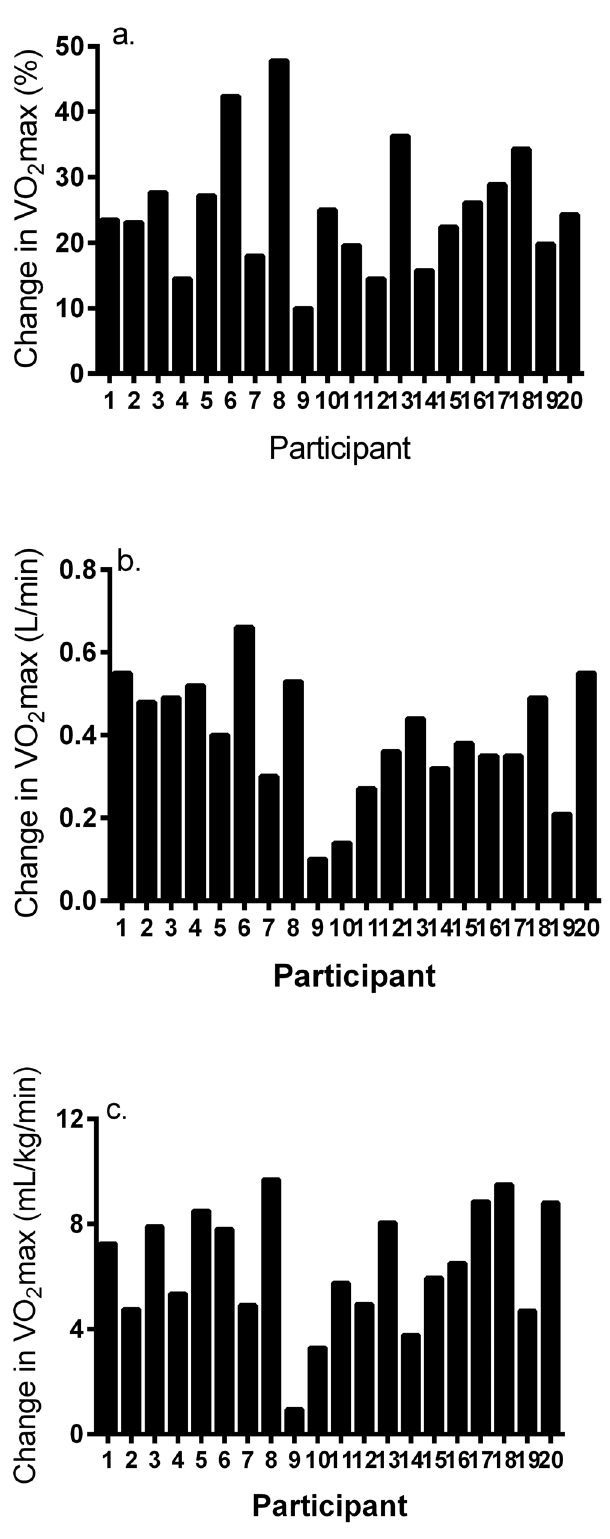
Figure 3. Individual responses for a) percent change in VO 2 max; b) absolute change in VO 2 max; and c) relative change in VO 2 max in response to 12 wk of high-volume interval training.